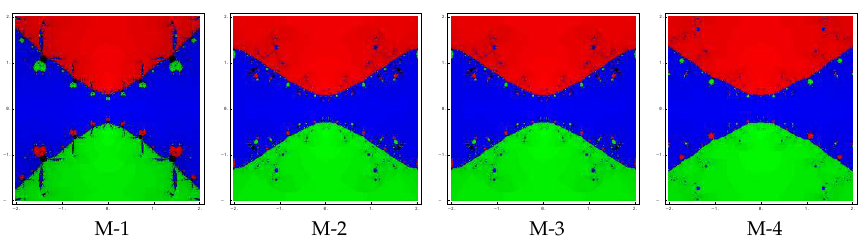
Figure 6. Basins of attraction by methods M-1–M-4 ( β = 10 − 6 ) for polynomial ψ 2 ( z ) .